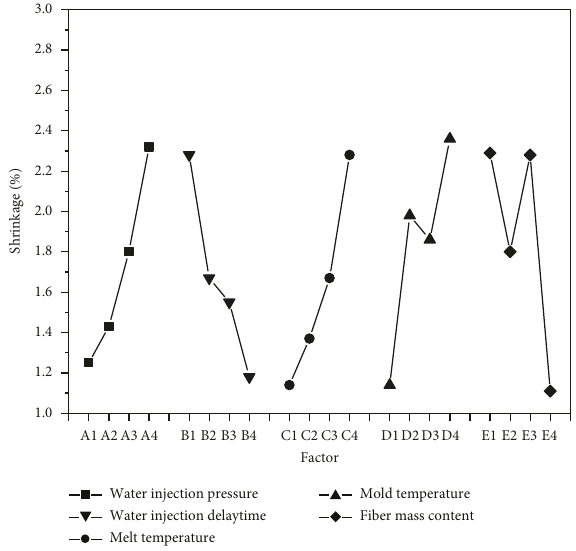
Figure 4: Effects of factors on shrinkage.